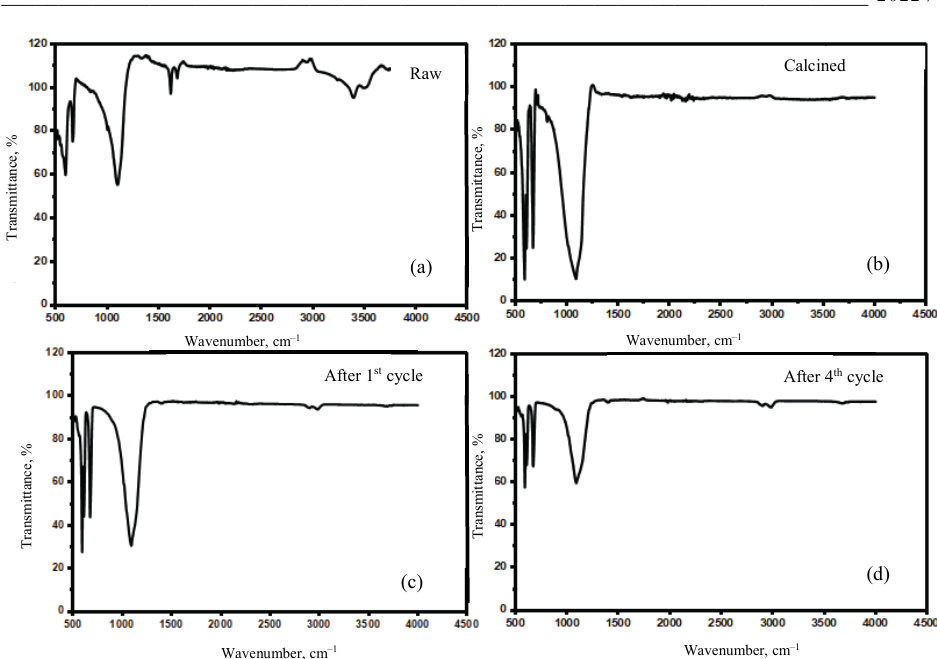
Fig. 1. Results of Ftir plots for: (a) raw, (b) calcined, (c) and (d) reused